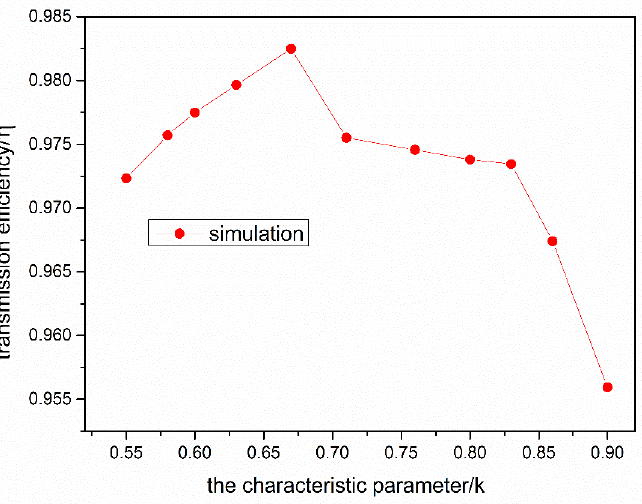
Figure 4. Variation curve of light transmission efficiency with characteristic parameters.